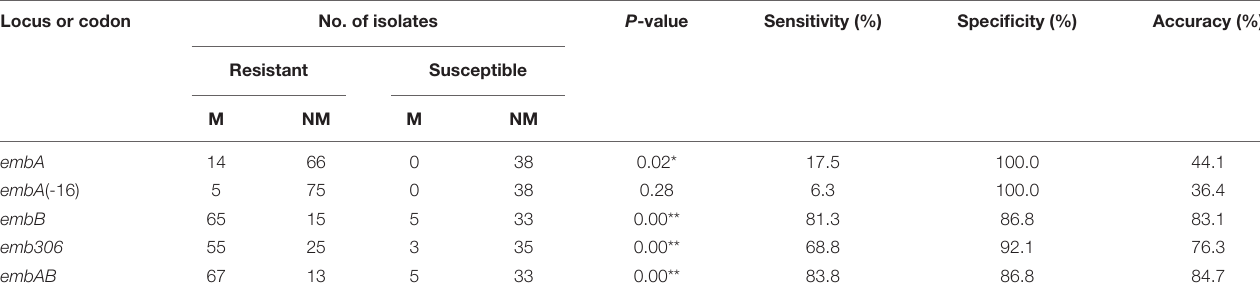
TABLE 4 | Summary of DNA sequencing of embAB and MABA. Locus or